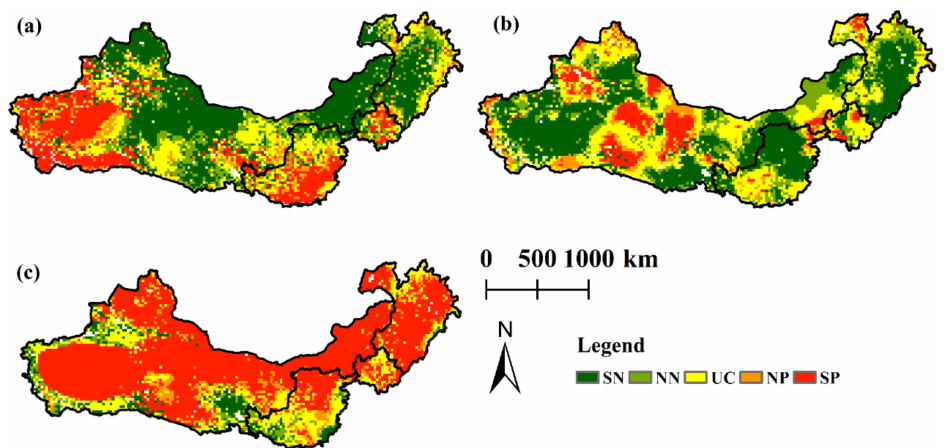
Figure 10. Spatial correlations between wind erosion and ( a ) spring mean temperature, ( b ) spring precipitation, and ( c ) spring average wind speed (SN: significant negative correlation; NN: nonsignif- icant negative correlation; UC: uncorrelated; NP: nonsignificant positive correlation; SP: significant positive